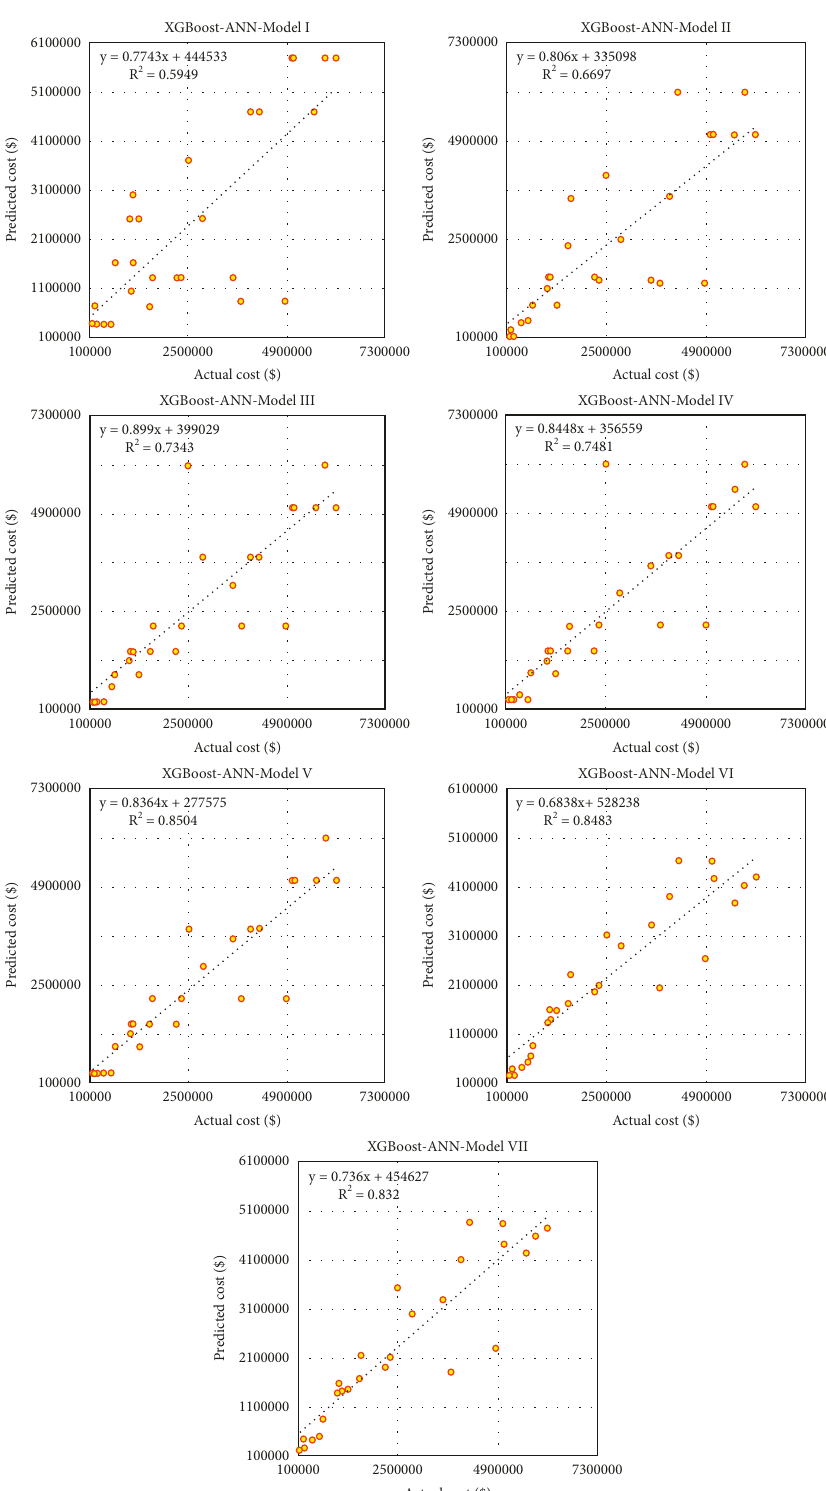
Figure 7: Scatter plot presentation of the XGBoost-ANN model for tested parameters (i.e., XGBoost-RF-Model VI) led to reducing MAPE to 0.25 and producing a residual plot with no outlier points.